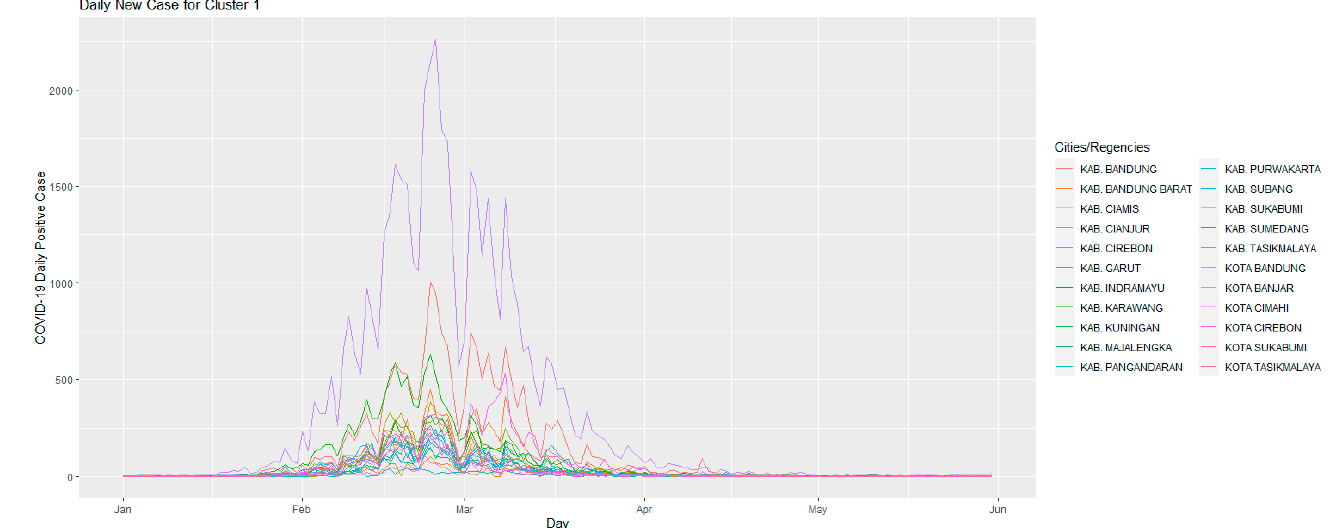
Figure 8. Daily positive cases of COVID-19 in Cluster 1 for the second period.